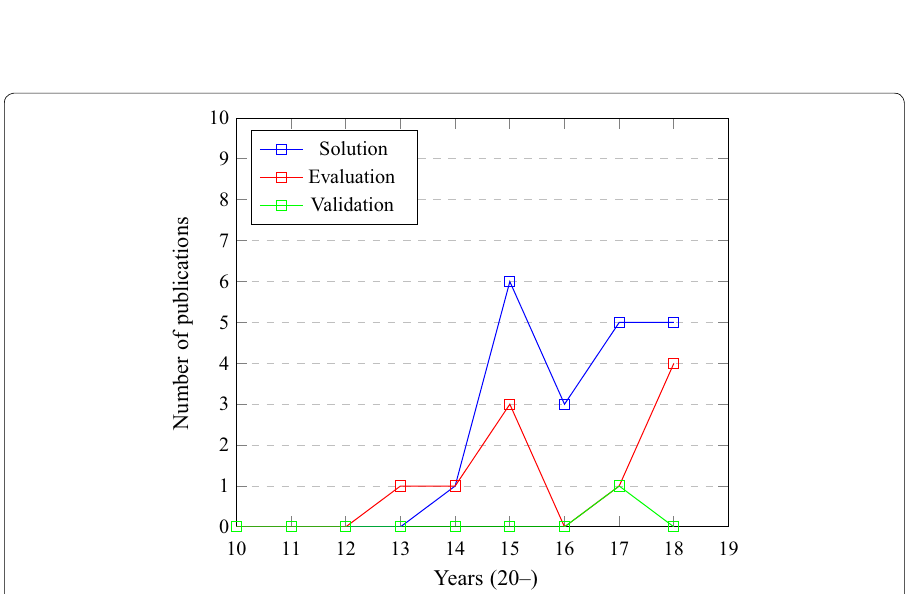
Fig. 4 Distribution of types of research throughout the last ten years. The figure depicts the distribution of the proposed research within the last 10 years, taking into account the type of these studies, solution, evaluation or